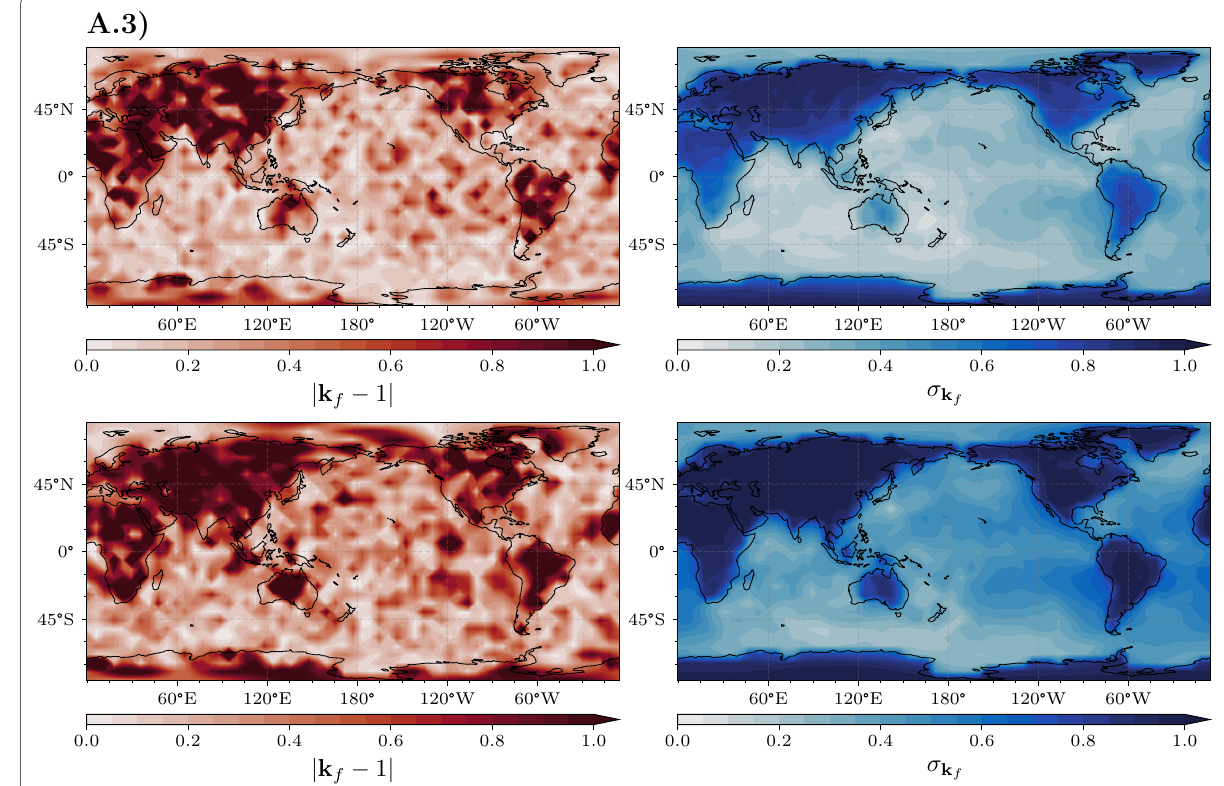
Fig. 8 The assimilation results for the ideal test case scenario, but with an increased spatial resolution of the ionospheric field. The results are obtained using the additional spatial correlation. On the top, the ionospheric component is simulated up to SH 10 and on the bottom up to SH 50. In both cases, the left side presents the absolute deviation to the final scale factor k f from the true value of 1, and the associated uncertainty (posterior standard deviation) of the final scale σ k f is shown on the right